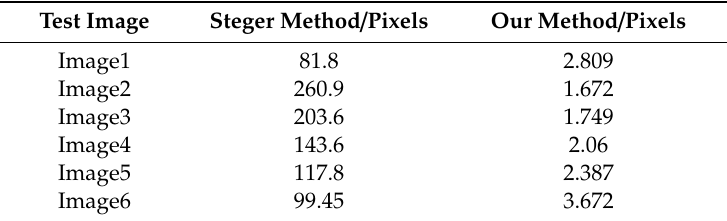
Table 6. The average pixel error of laser stripe center